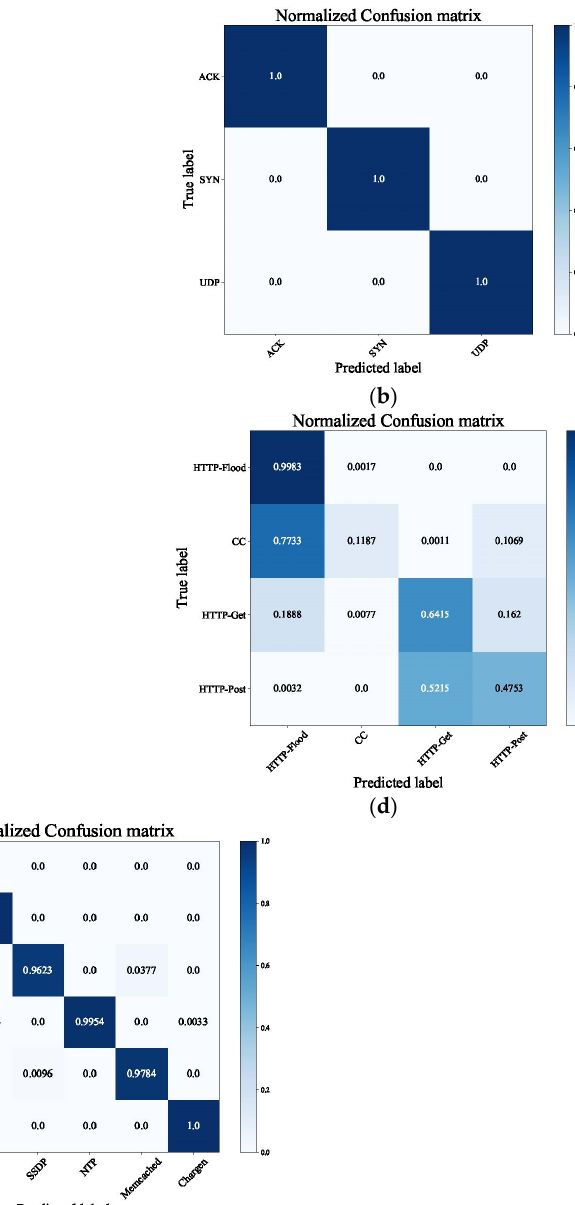
Figure 11. Normalized confusion matrix. ( a ) Botnet normalized confusion matrix; ( b ) Network normalized confusion matrix; ( c ) LDDoS normalized confusion matrix; ( d ) Application normalized confusion matrix; ( e ) DRDoS normalized confusion matrix.